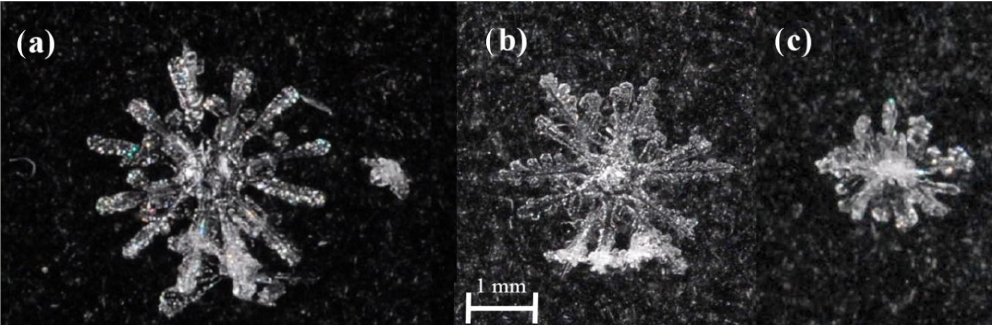
Figure 7. The 12-branched dendrites were identified on 5 April 2015 at (a) 03:34UTC, (b) 03:41UTC and (c) 05:12UTC. The scale is the same for each particle. These particles ranged in size from approximately 2 to 4mm across and were lightly rimed. The average temperature when the particles were photographed at the surface was − 2 ◦ C with an average relative humidity of